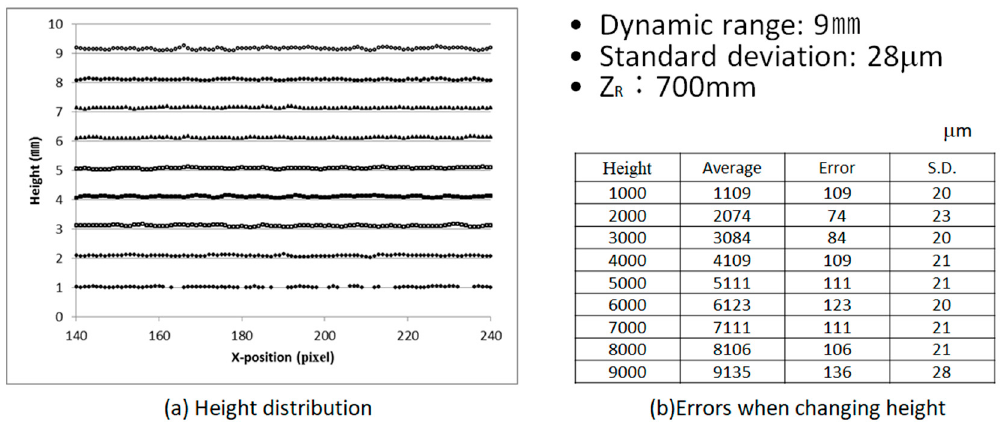
Figure 8. Results of height error and standard deviation of a flat